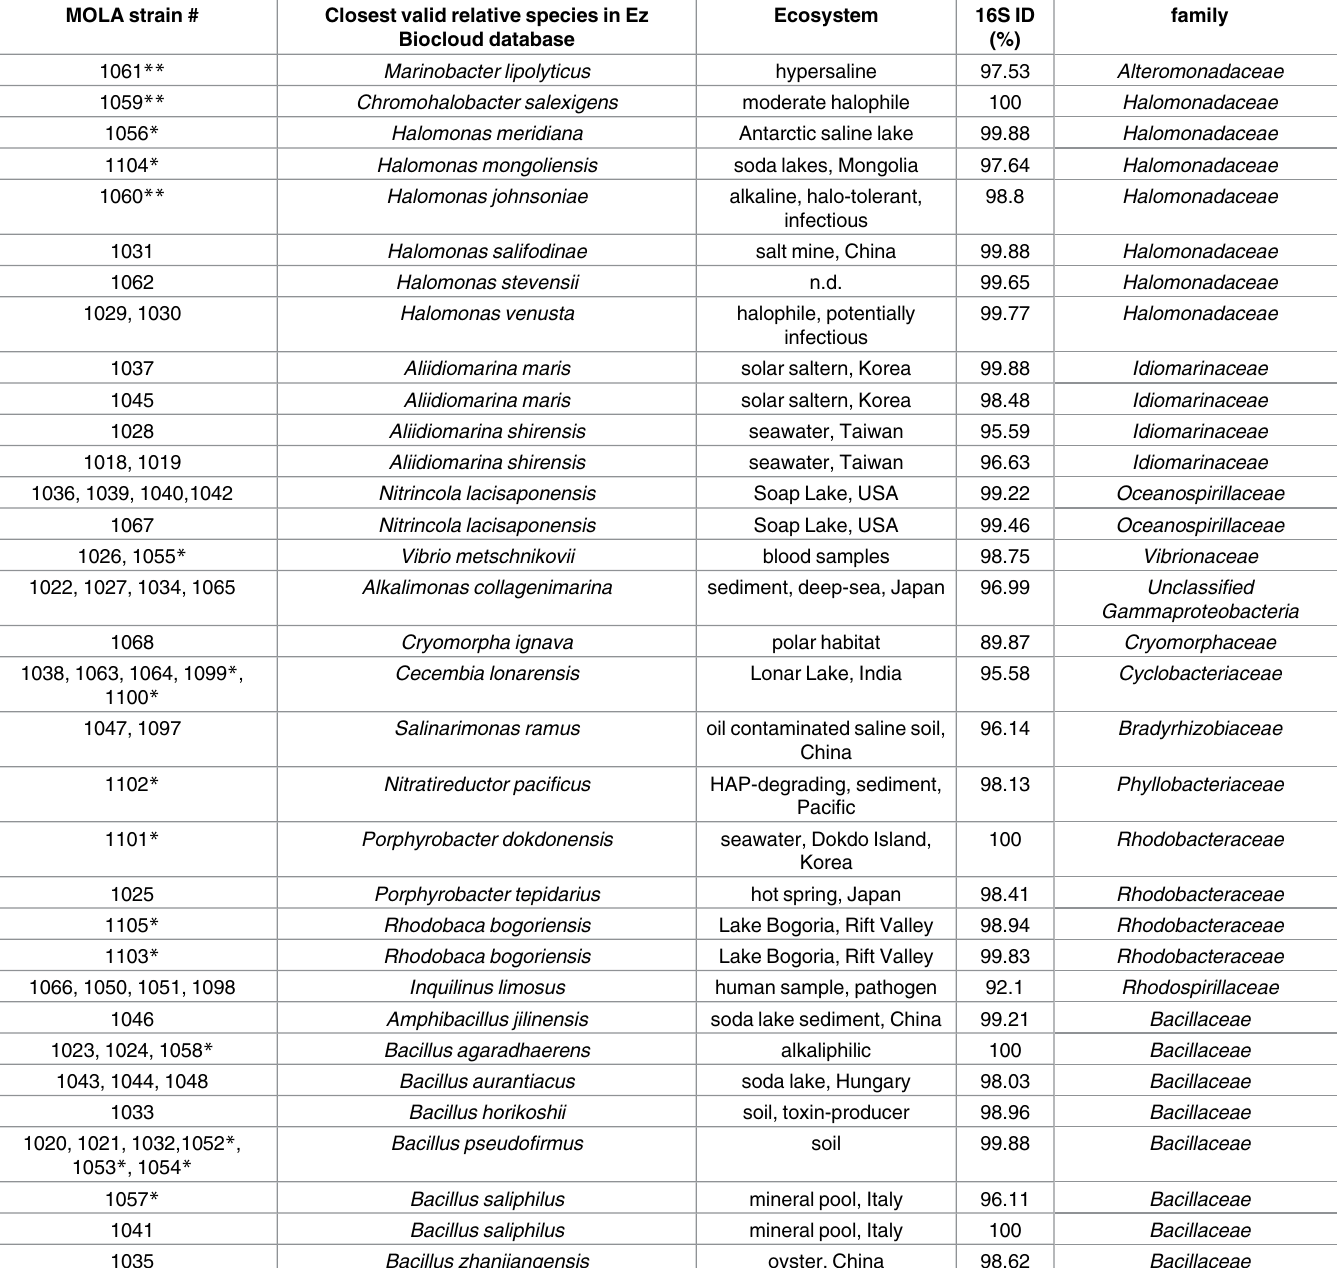
Table 5. List of the 59 Eubacteria strains isolated from Dziani Dzaha. MOLA strain